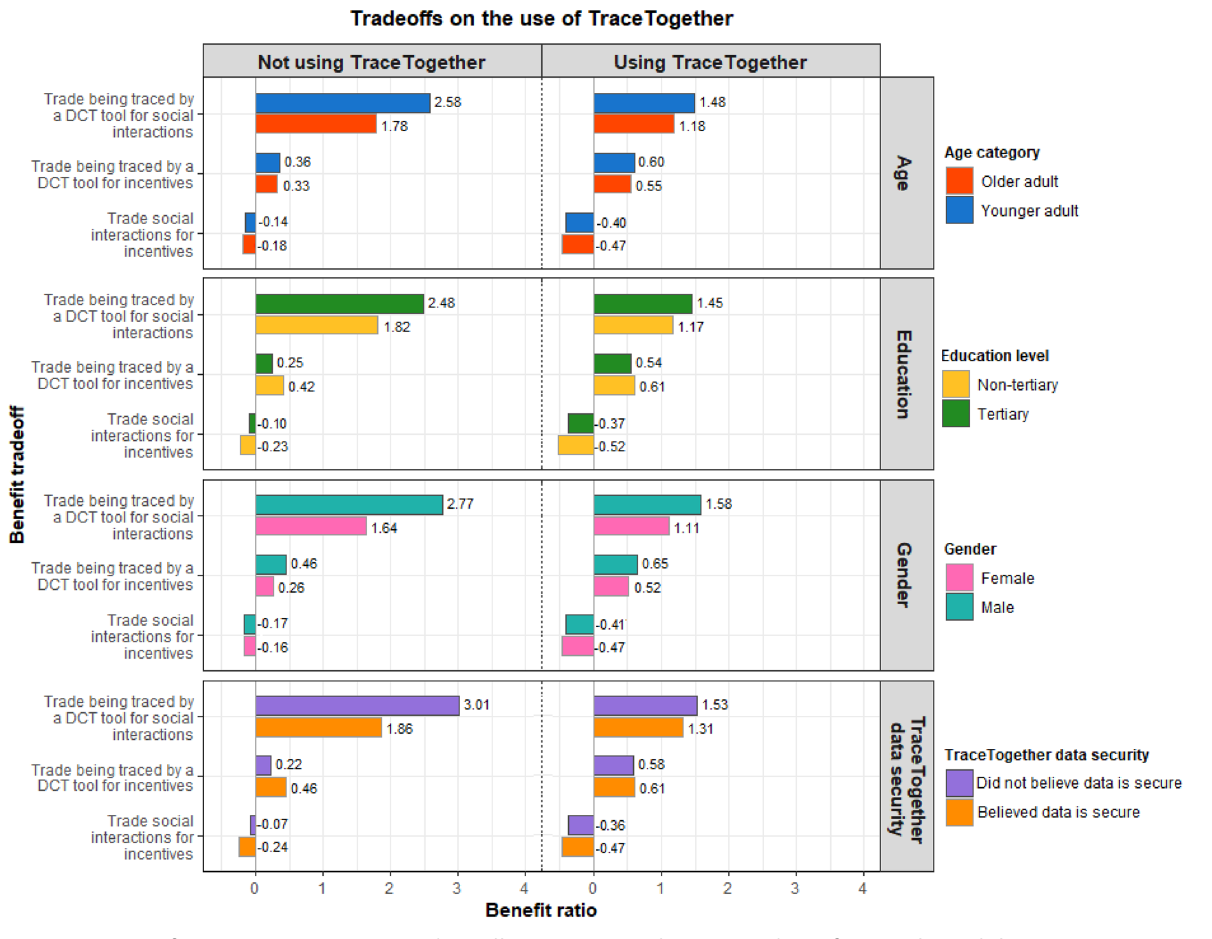
Figure 2. Satisfaction derived from trade-offs between social interactions, incentives, and being traced by a